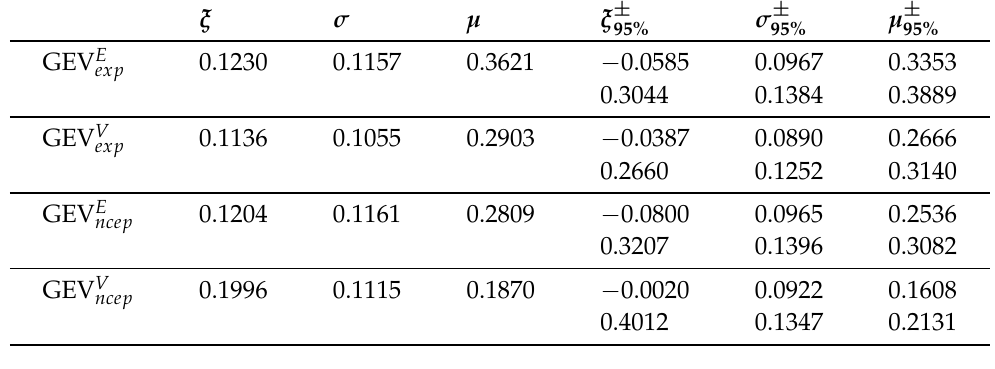
Table 3. Estimated parameters for the GEV distribution and the confidence intervals at a 95% confidence level.